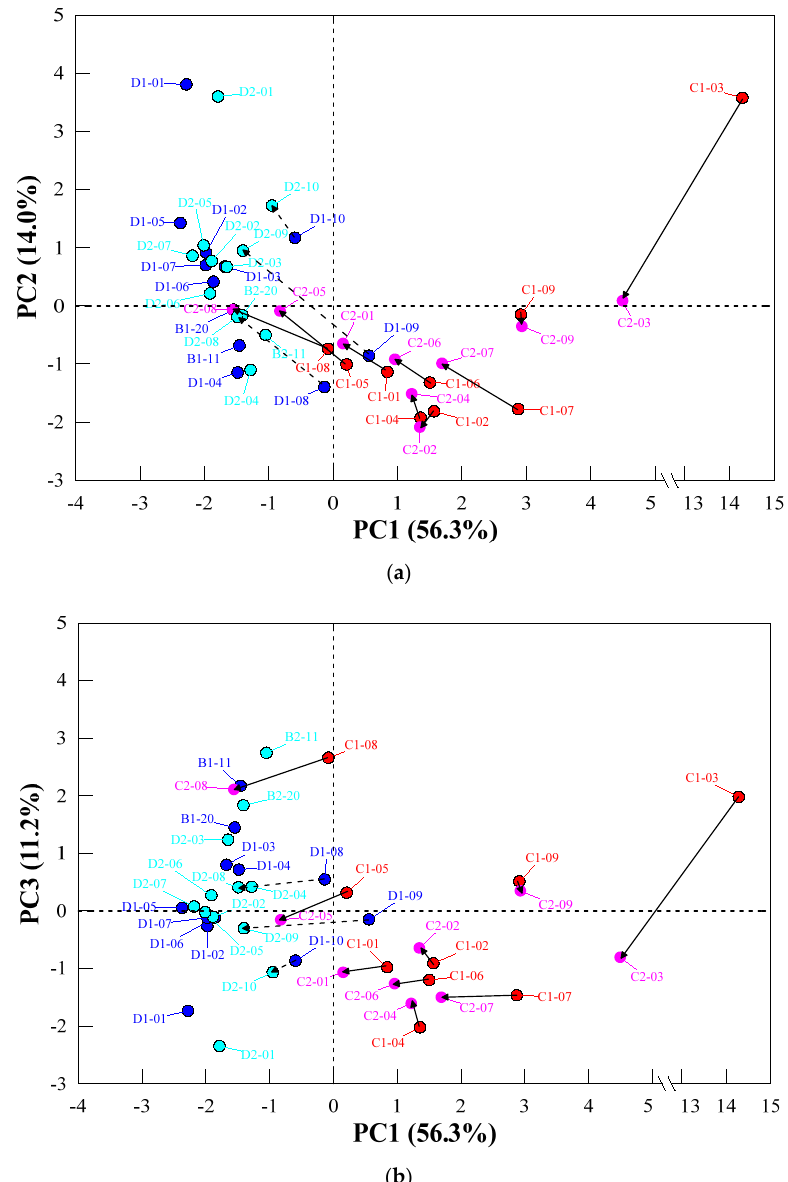
Figure 8. Results of principal component analysis (PCA): ( a ) PC1 vs. PC2 and ( b ) PC1 vs. PC3. Arrow direction indicates water quality change from the first survey in July 2019 to the second survey in October 2019. Each well label represents well ID and sampled survey; for example, C1-01 means C-01 well sampled in the first survey, C2-01 sampled in the second survey.